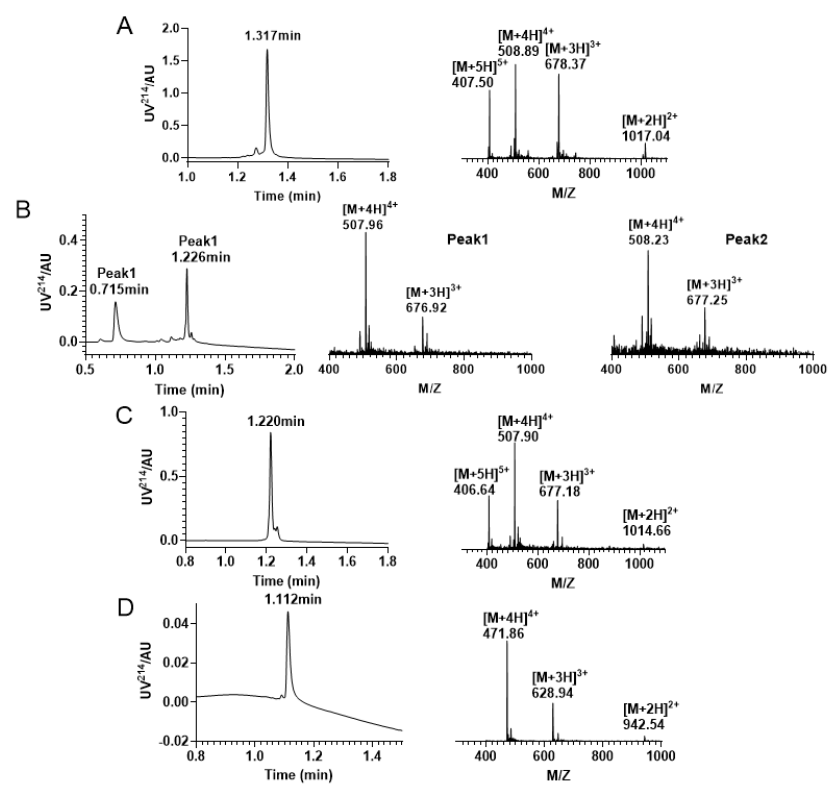
Figure 5. RP − UPLC and mass spectrogram monitoring of each step of reaction under Trt/Trt/Acm strategy folding. ( A ) RP − UPLC diagram of linear KIIIA with a retention time of 1.317 min and mass of 2032.11 Da; ( B ) A mixture of four pairs of free thiol free oxidation was observed. Peak 1 has a retention time of 0.715 min with a mass of 2027.76 Da; Peak 2 has a retention time of is 1.226 min with a mass of 2028.75 Da. ( C ) The RP − UPLC diagram of KIIIA with two disulfide bonds and two Acm-protecting groups, with a retention time of 1.220 min and a mass of 2028.54 Da. ( D ) RP − UPLC diagram of the purification after removal of the Acm protecting group to form the third pair of disulfide bonds, with a retention time of 1.112 min and a mass of 1883.82 Da.